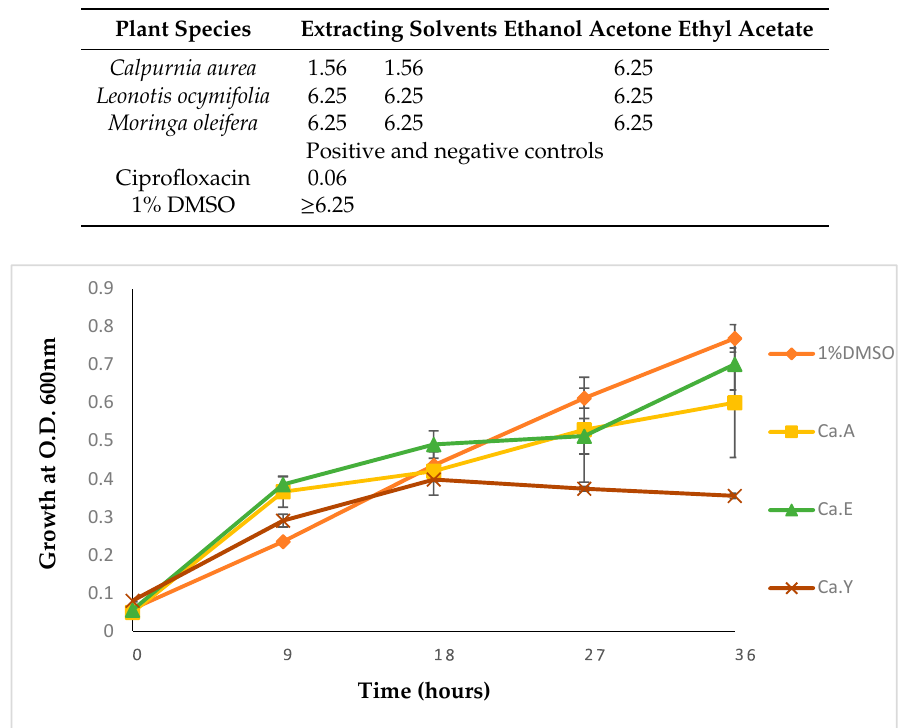
Table 1. Minimum inhibitory concentration (MIC) mg/mL for plant extracts tested against the bacteria Pseudomonas aeruginosa .